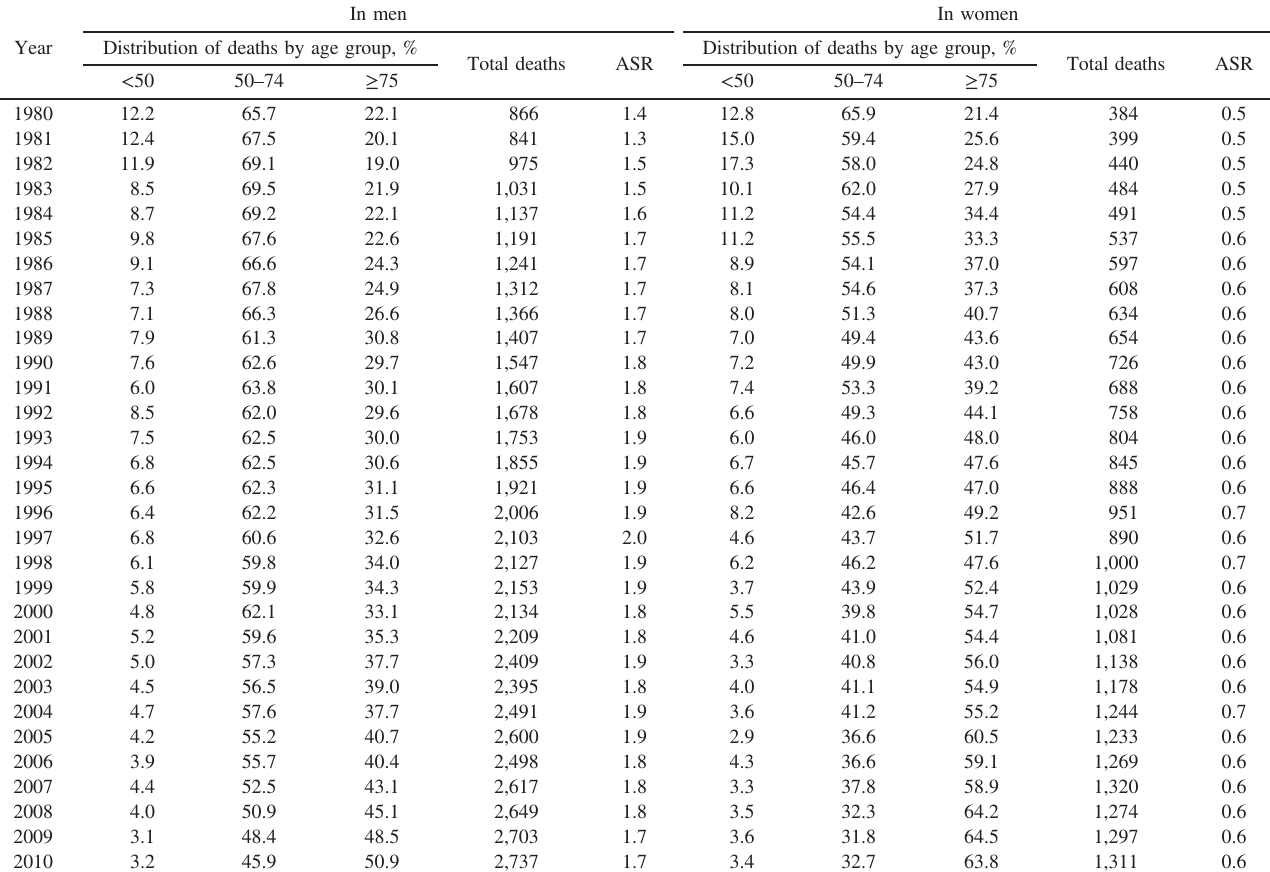
Table 1. Number of deaths, and age-standardized rate (ASR a ) for deaths caused by kidney cancer in Japan, 1980 – 2010 In men In women Year Distribution of deaths by age group, % Total deaths